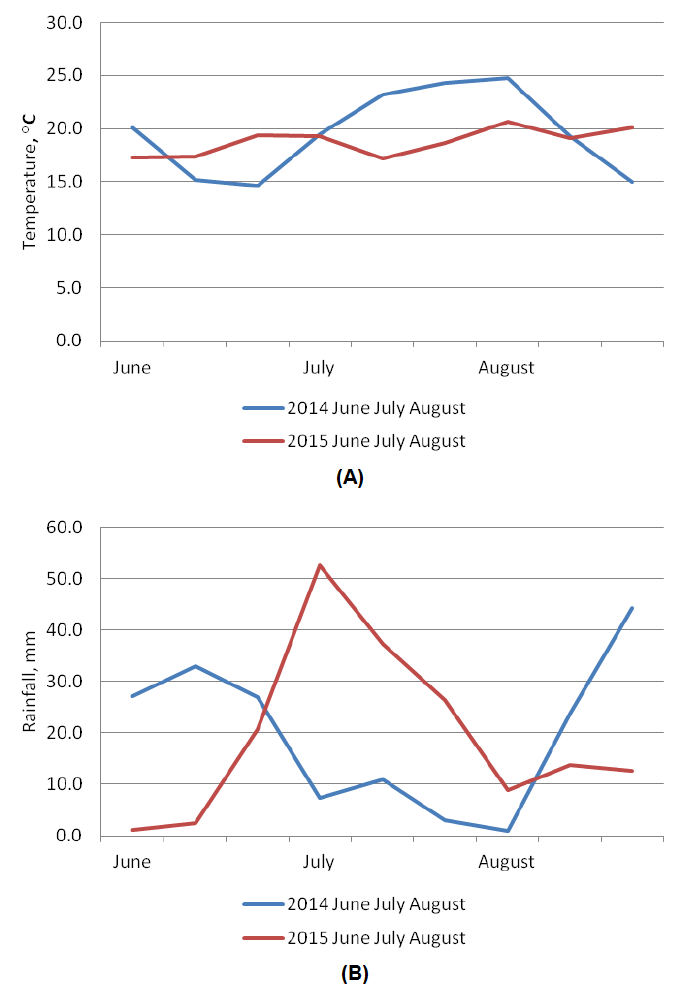
Figure 4. Diagrams of weather conditions: air temperature ( A ) and rainfall ( B ) in 2014–2015.